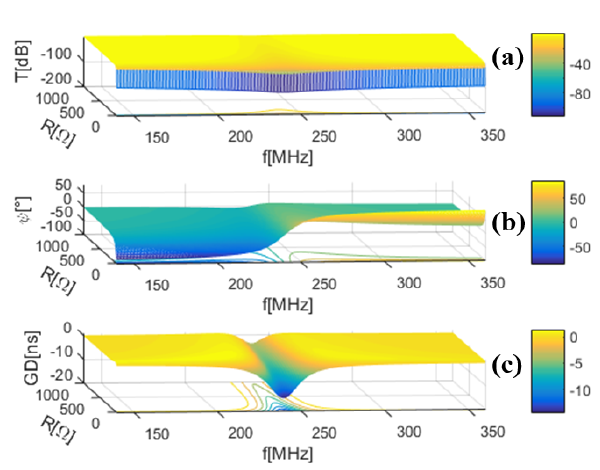
FIGURE 8. Variations of the VTF magnitude, phase and GD with respect to resistance R variation in the range from 1 m Ω to 1 k Ω .